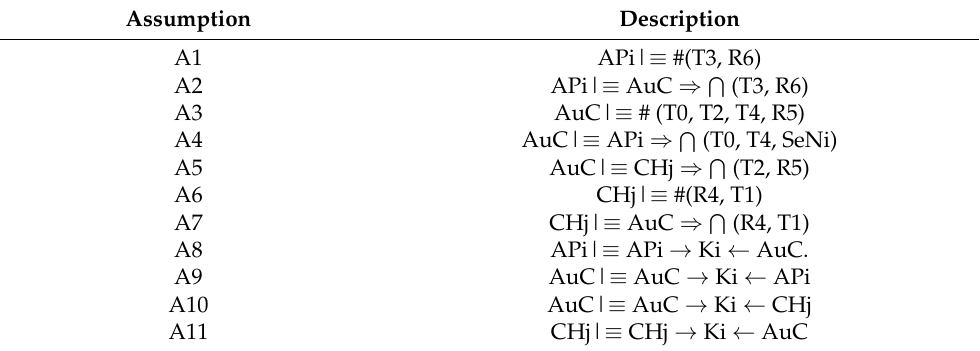
Table 7. Assumptions of the authentication and key agreement phase.